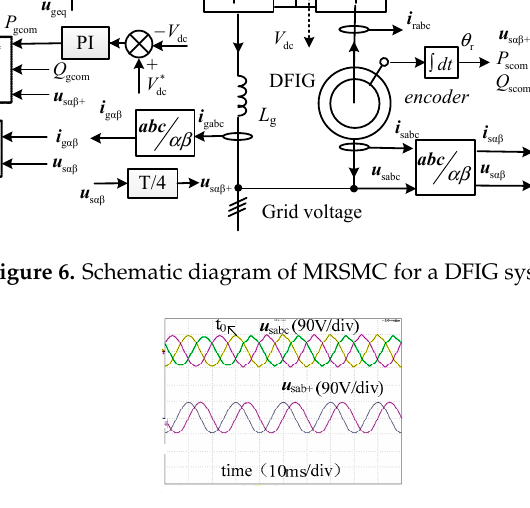
Figure 7. Experimental results of the T 1 /4 delay technique.